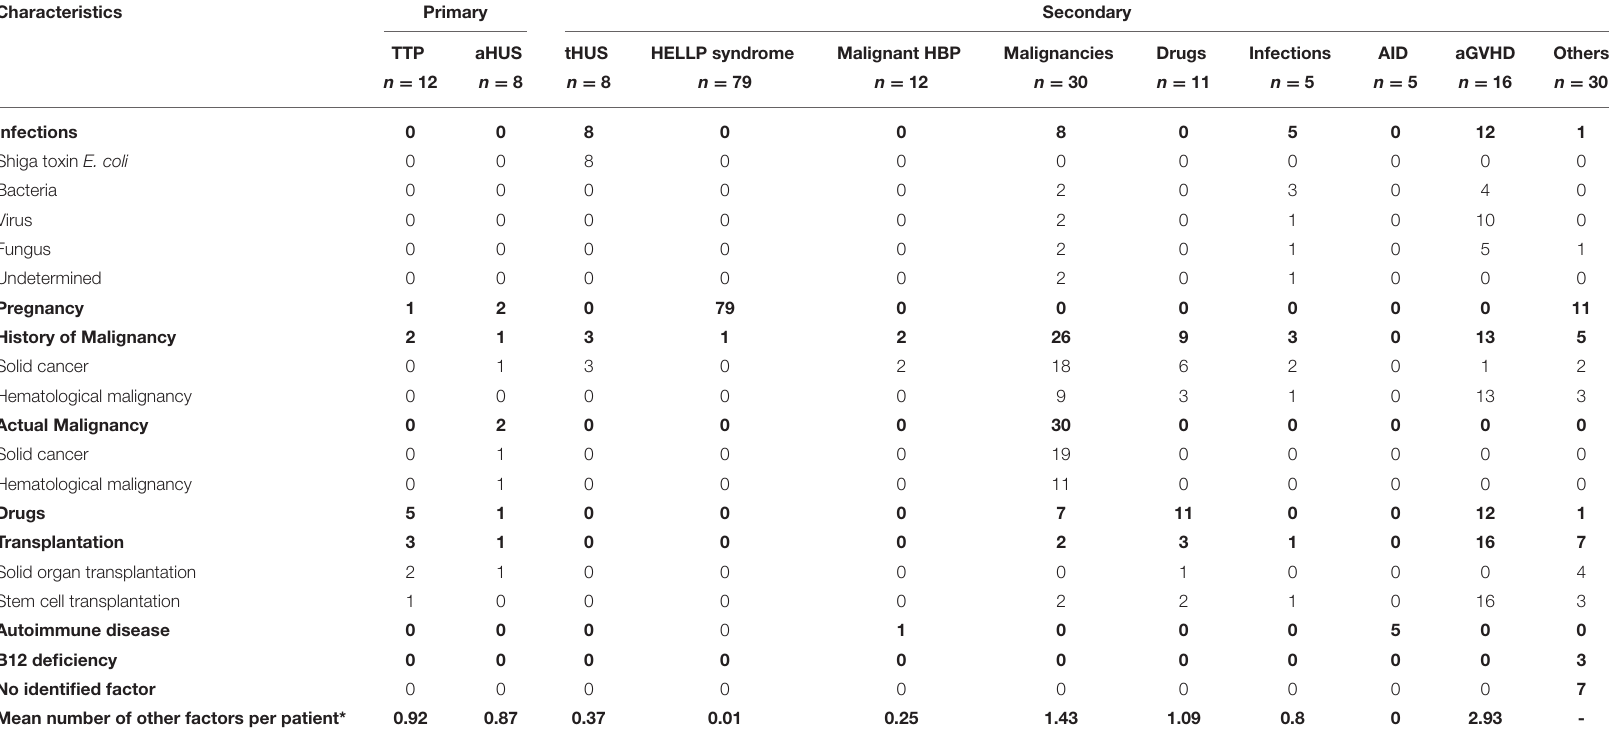
TABLE 2 | TMA-favoring factors according to TMA